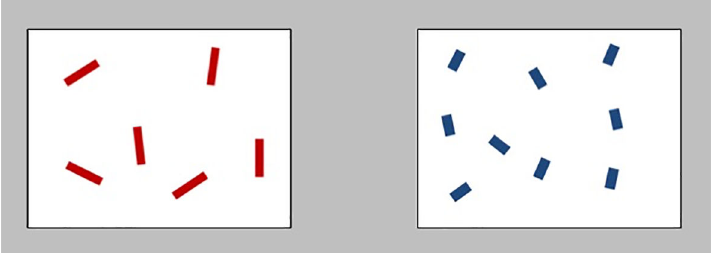
Figure 5b. A 2:3 ratio comparison in the large numerosity condition in Experiment 3 (size-number incongruent).